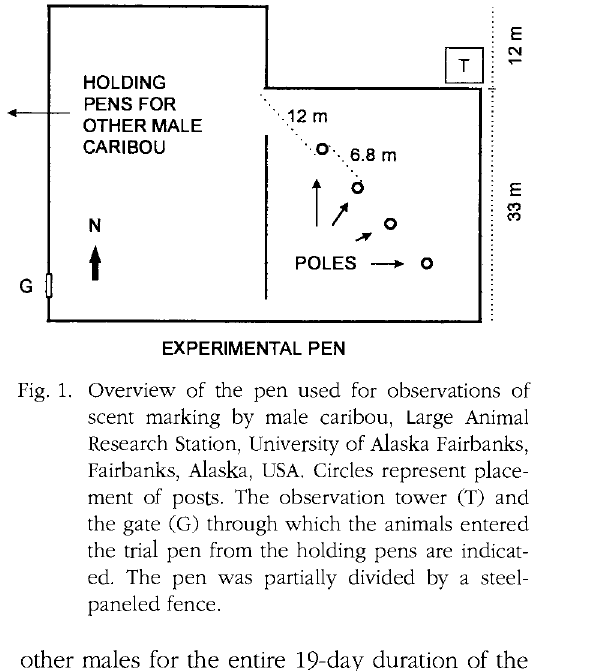
Fig. 1. Overview of the pen used for observations of scent marking by male caribou, Large Animal Research Station, University of Alaska Fairbanks, Fairbanks, Alaska, USA. Circles represent place ment of posts. The observation tower (T) and the gate (G) through which the animals entered the trial pen from the holding pens are indicat ed. The pen was partially divided by a steel- paneled